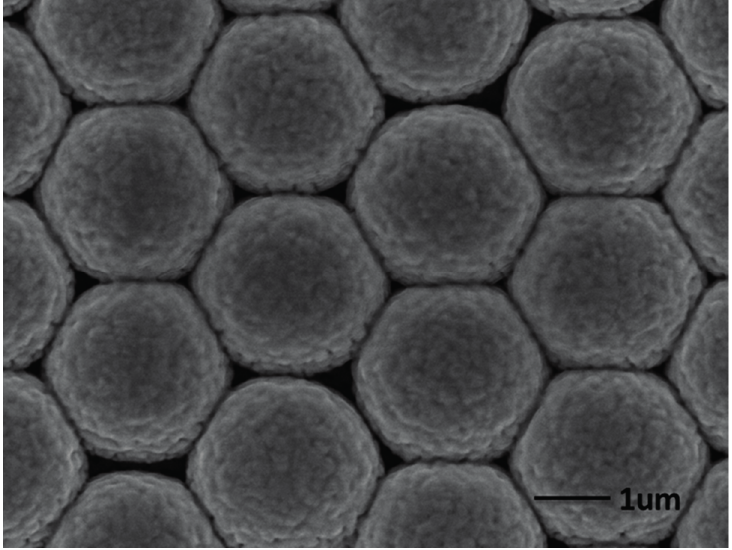
Figure 3. FE-SEM images of the Au film over nanosphere (AuFON)